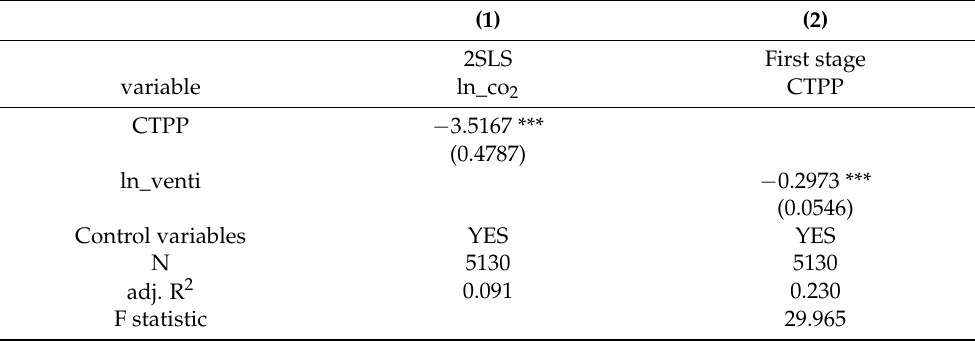
Table 3. Two-stage regression